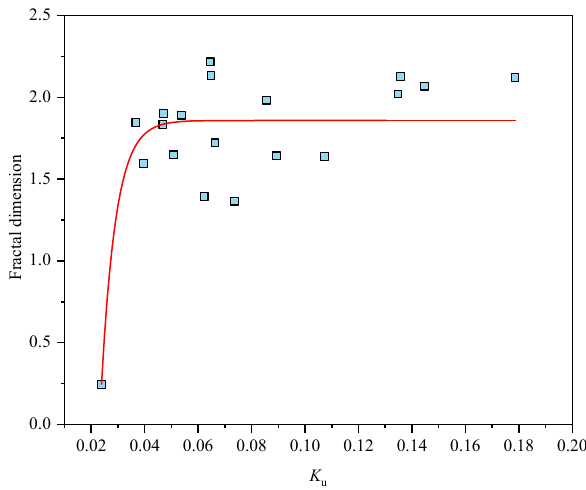
Figure 8. The curve of K u and fractal dimension.